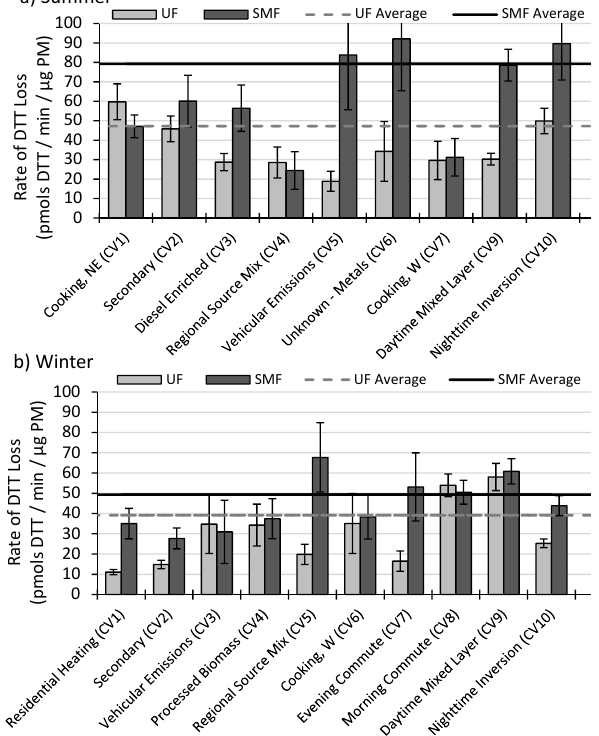
Figure 2. PM-mass-normalized rate of DTT loss for (a) summer and (b) winter. Lines represent the mass-weighted, average DTT loss over all CVs for UF (dashed line) and SMF (solid line) in a given season. Error bars are 1 standard deviation of replicates ( n = 2–3) with the propagated error of the filter